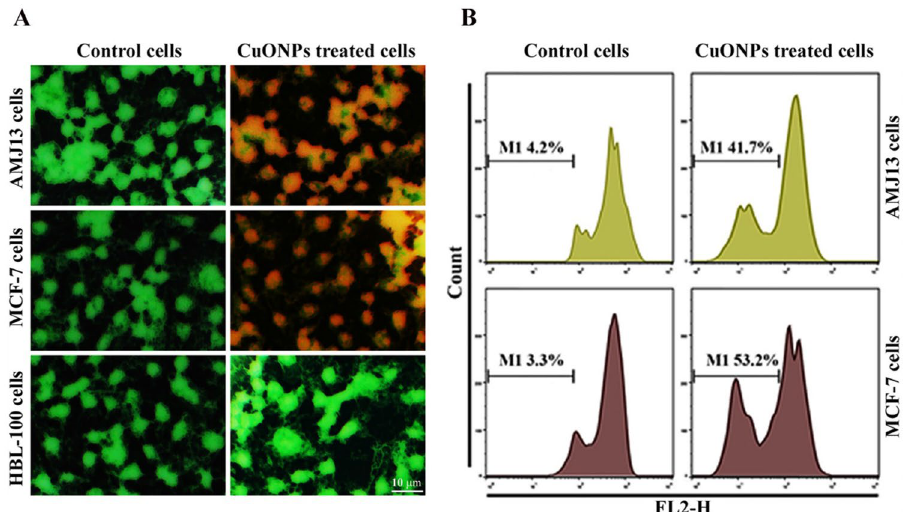
Figure 6. Apoptosis markers in cancer cells after treatment with CuO NPs. ( A ) Apoptotic indicators for AMJ- 13, MCF-7, and HBL-100 cells exposed to CuONPs at IC 50 concentrations for 24 h and stained for 2 min using AO/EtBr. Unexposed cells have an intact structure. Nevertheless, CuONPs exposure correlated with apoptotic aspects indicated using red stains. Scale bar 10 µm. ( B ) Cells cycle phase. Sub-G 1 phase concerning MCF-7 and AMJ-13 cells’ flow